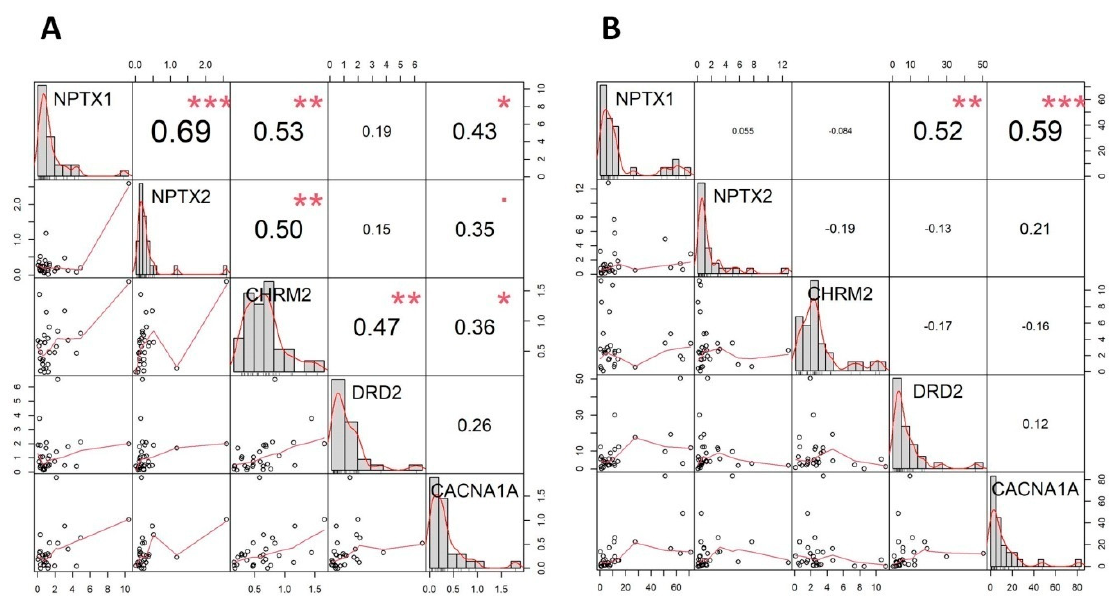
Figure 4. Correlation matrices. ***: significant at 0.001; **: significant at 0.01; *: significant at 0.05. ( A ) normal myometrium; ( B ) fibroid tumor.